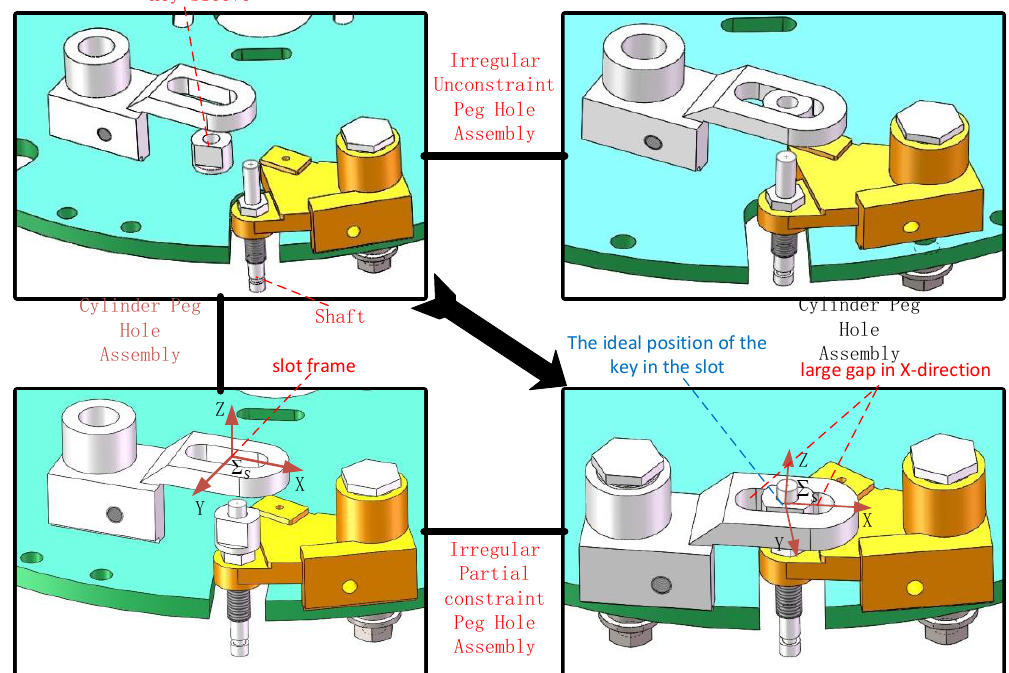
Figure 3. Possible assembly sequences for the coupling mechanism.